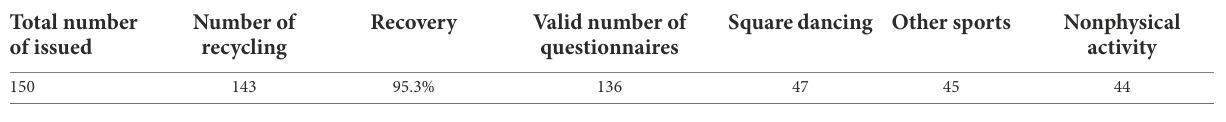
TABLE 3 The results of the distribution and recovery of the questionnaire.